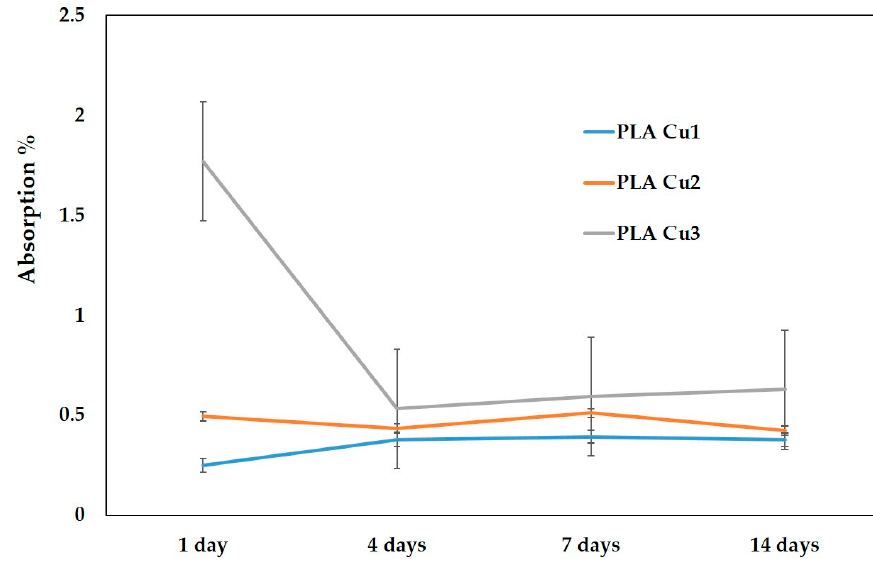
Figure 11. Absorption of the saline solution (%).